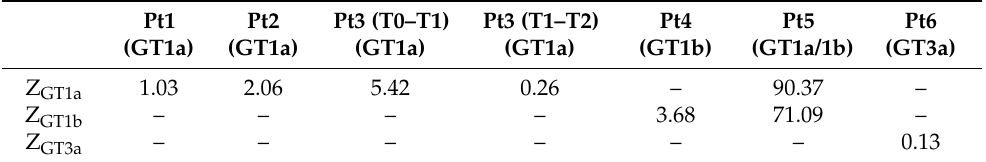
Table 3. Z-scores absolute values; ZGT1a, ZGT1b, and ZGT3a are calculated for the same genotype